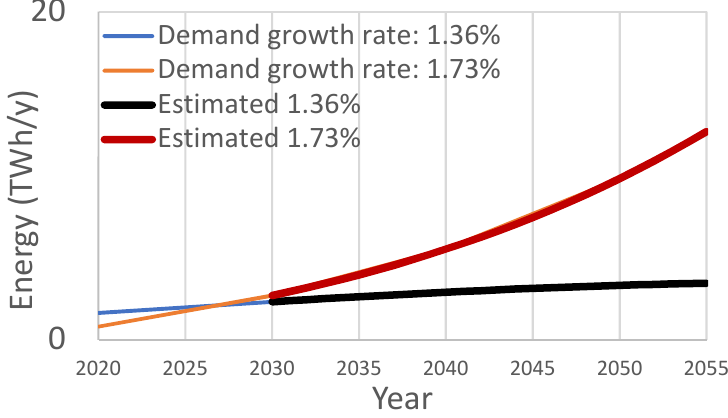
Figure 2. Estimated surplus energy in Spain for the two limiting scenarios of 1.36% and 1.73% growth demand.